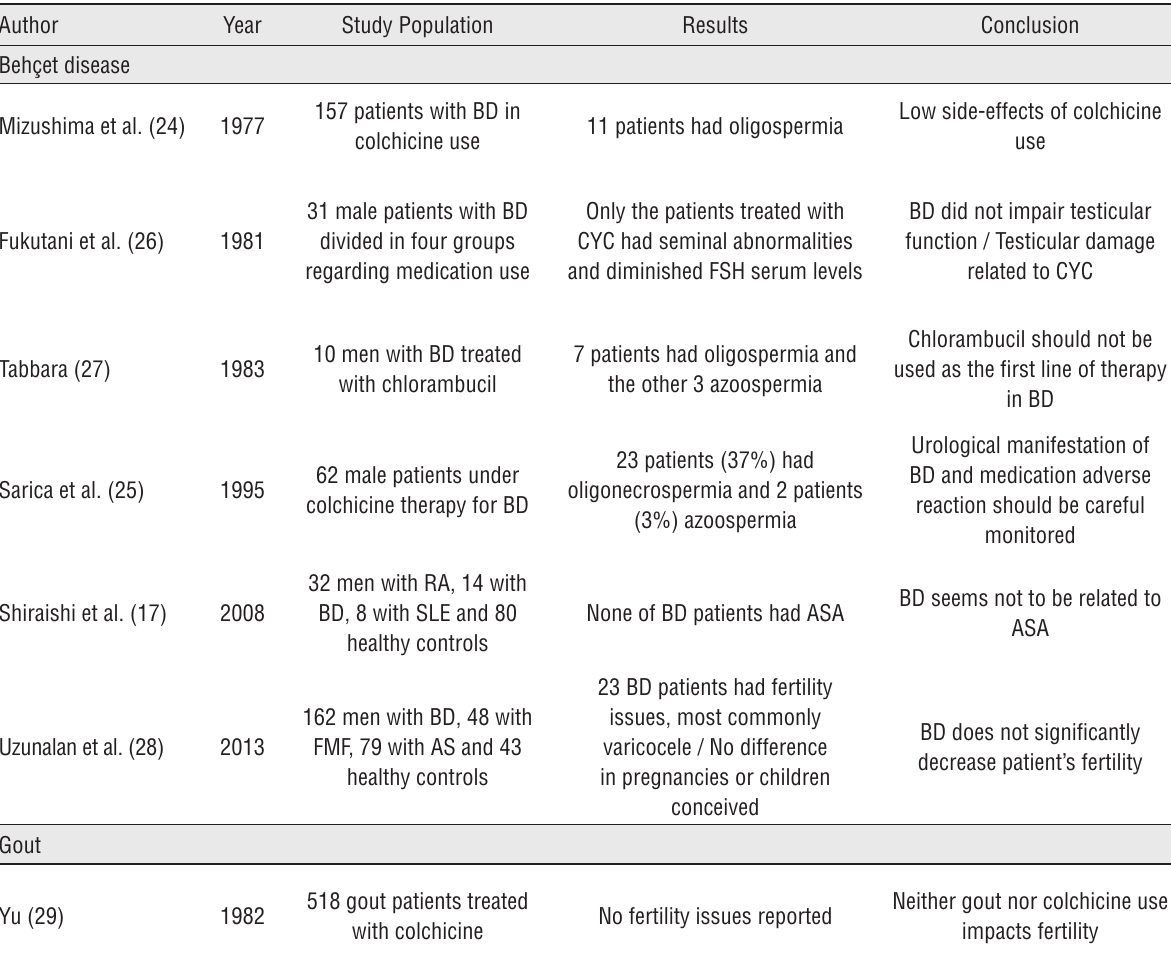
Table 5 - behçet disease, gout and male